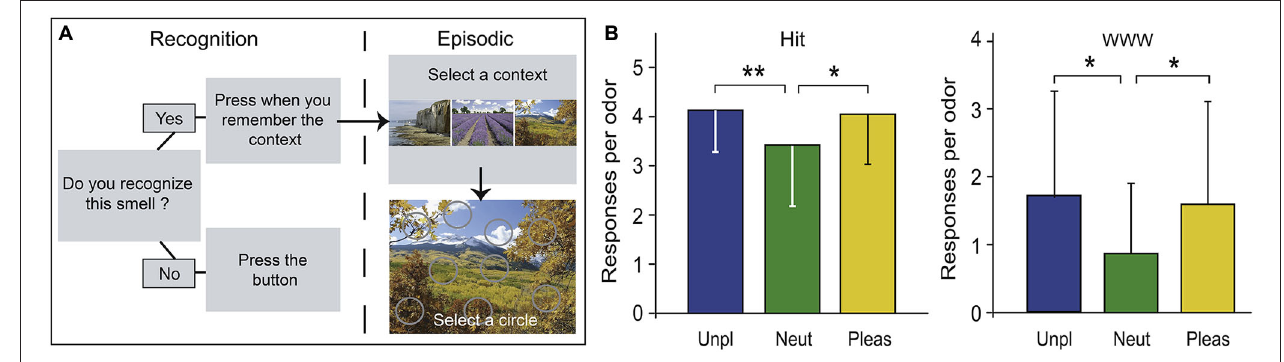
FIGURE 7 | Laboratory-ecological approach for studying episodic memory. (A) Episodic-memory task design. The memory of the episodes was tested using an odor recognition task followed for the “Yes” trials by an episodic memory retrieval (selection of a visual context and a location).